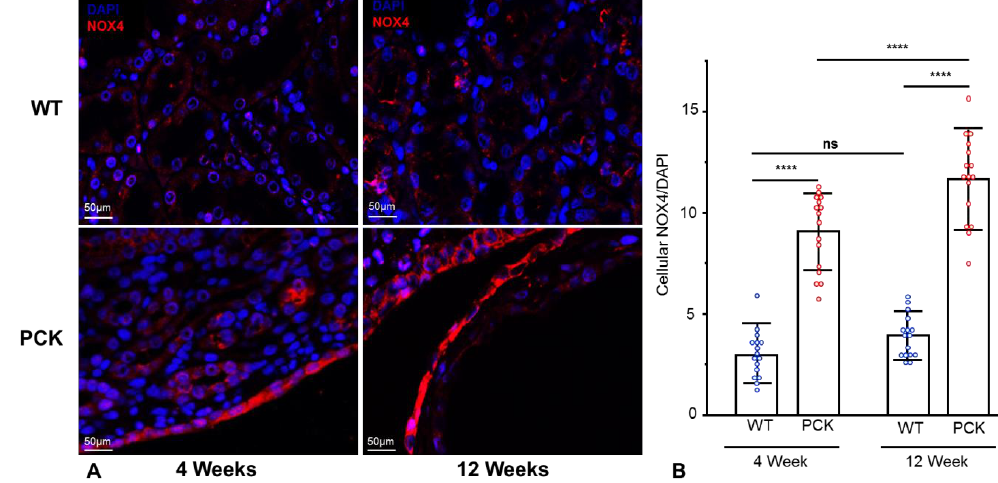
Figure 4. Renal NOX4 is upregulated in tubular epithelial cells in PKD. Representative immunofluorescence staining for NOX4 (red) in renal tissue sections of WT and PCK rats ( A ) and its quantification ( B ), showing increased NOX4 immunoreactivity in PCK vs. WT rats at 4 weeks, which further increased at 12 weeks. **** p < 0.0001. NOX4 was quantified as % stained area and adjusted to DAPI-stained % area. (n = 16/group).